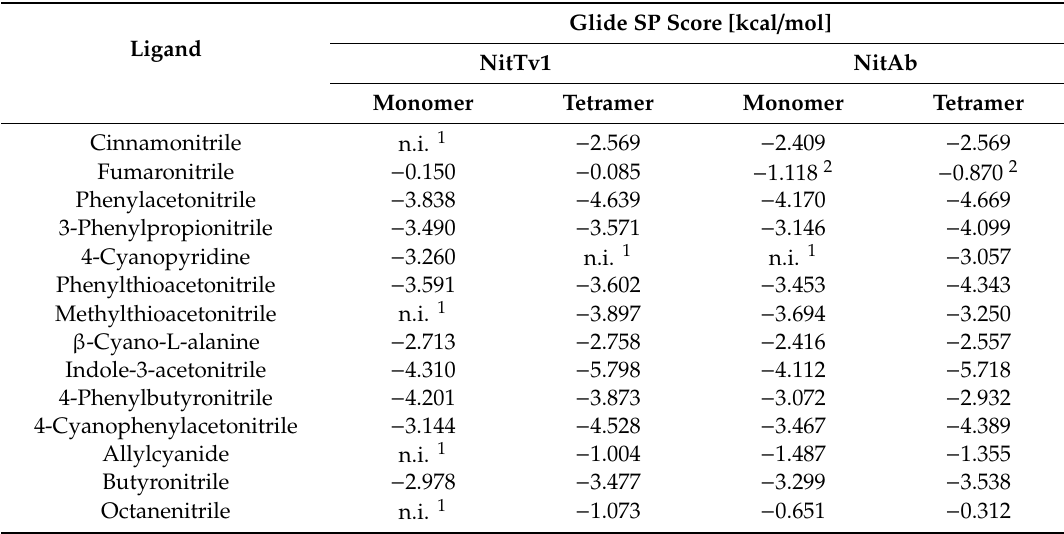
Table 4. Calculated binding Glide SP